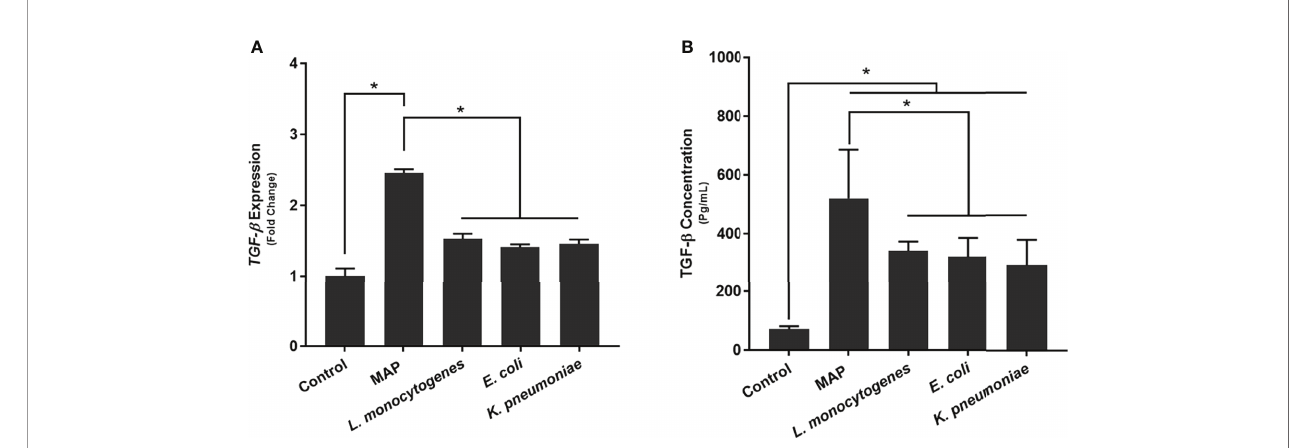
FIGURE 3 | The (A) expression and (B) production of TGF- b ligand in bacteria infected THP-1 derived macrophages. The Kolmogorov – Smirnov normality test was used to test the normal distribution for all values and a two-way analysis of variance (ANOVA) was used to assess signi fi cance among experiments, which was followed by a Bonferroni correction test. All experiments were performed in triplicates. *Indicates P-value of less than